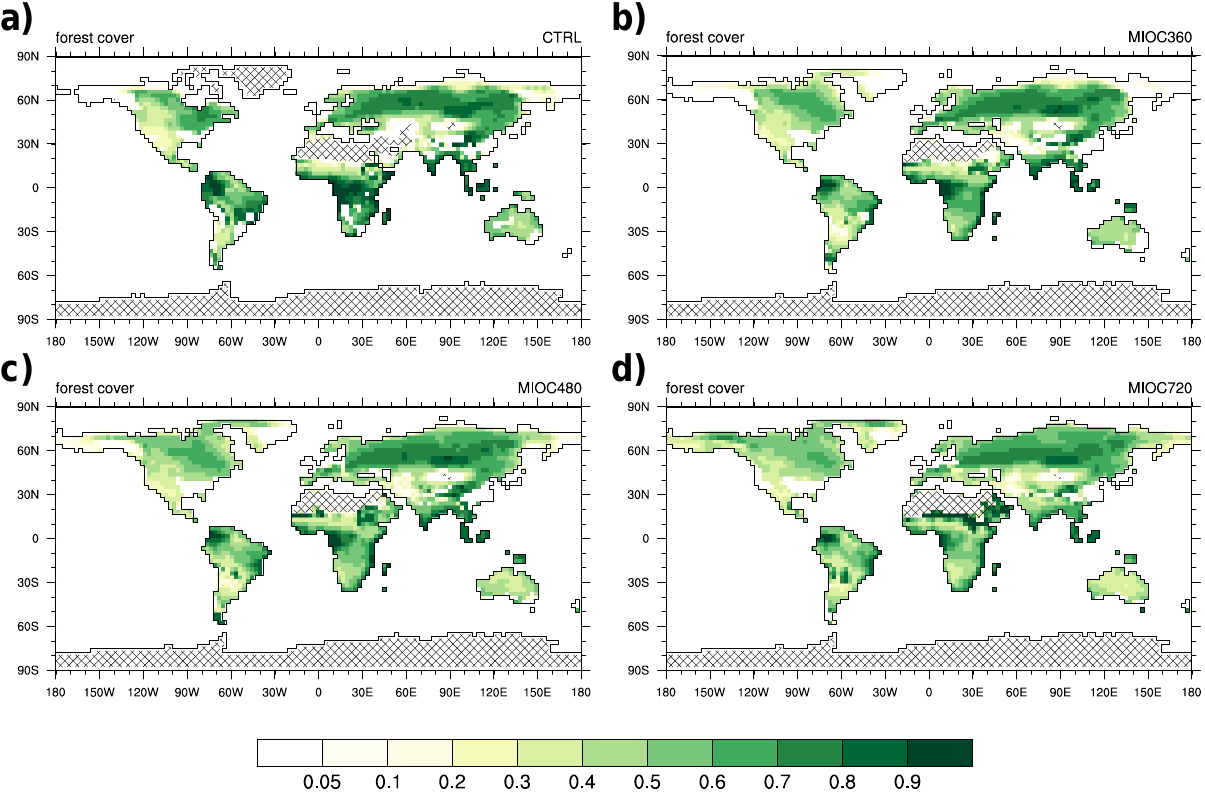
Fig. 5. Forest cover fraction for (a) CTRL, (b) MIOC360, (c) MIOC480, and (d) MIOC720. Crosshatched areas represent desert regions, including land ice, that cover more than 75%.